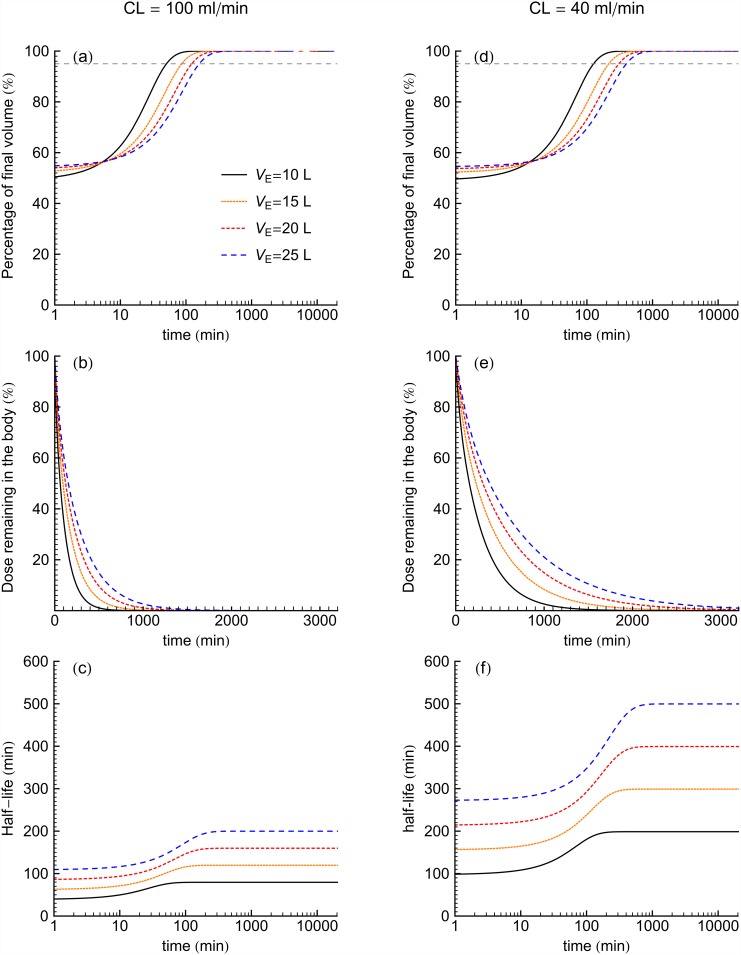
For E2 models for four VE values at CL of 100 ml/min (left panel) and 40 ml/min (right panel), the percentage of terminal apparent volume, percent dose mass in time and half-life of the drug as a function of time.Dashed horizontal line indicates 95% of final volume.